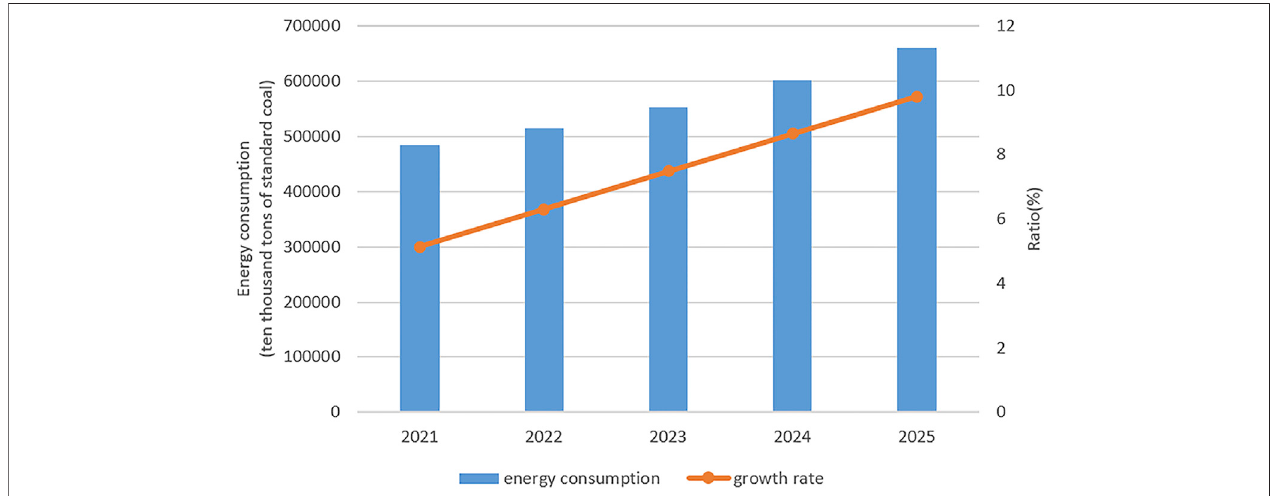
FIGURE 9 | Forecast value of China ’ s energy consumption during the 14th Five-Year Plan period.